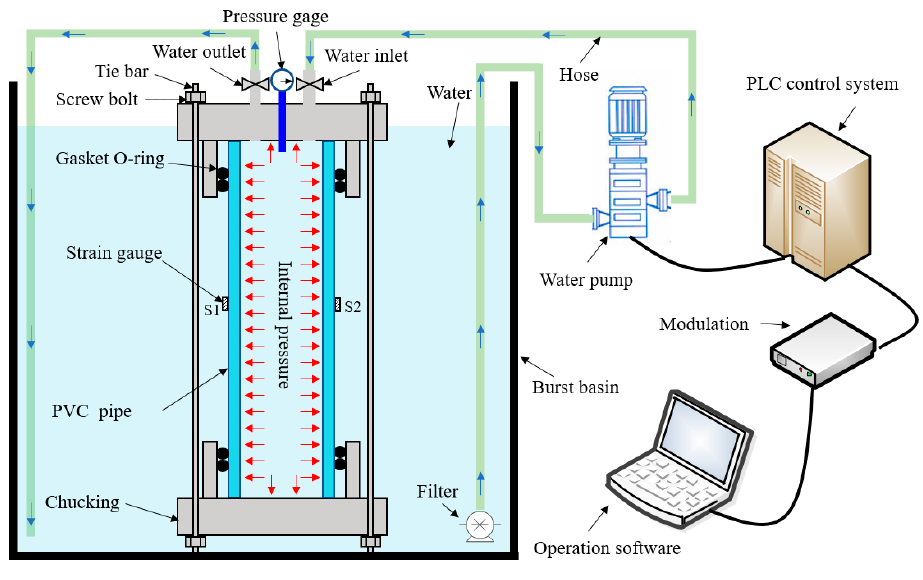
Figure 9. The burst test schematic.